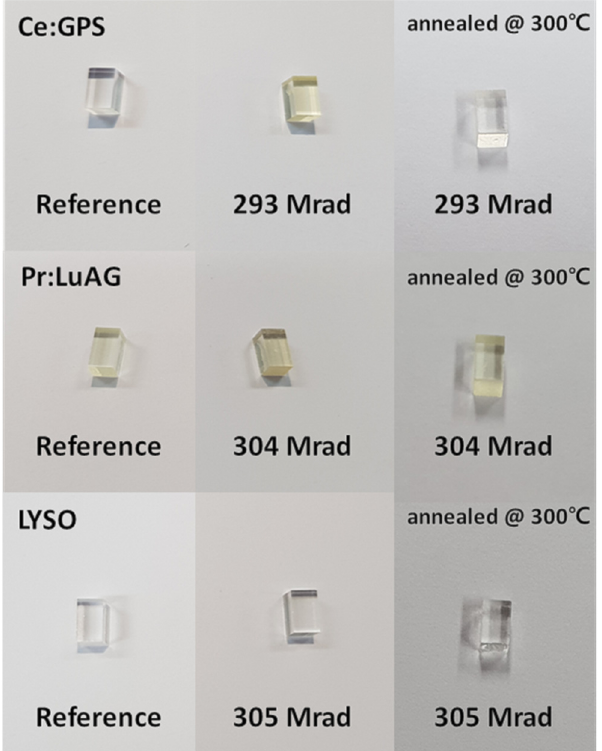
Figure 3. Changes in the colors of Ce:GPS, Pr:LuAG, and LYSO scintillators before and after gamma-ray irradiation and thermal annealing at different radiation doses. Reproduced with permission of Ref. [22].